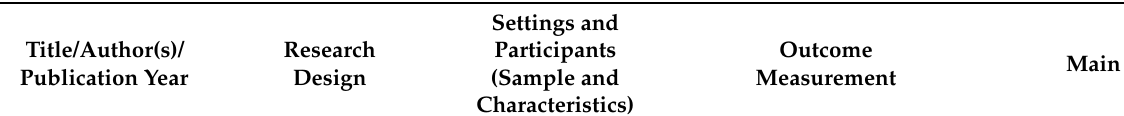
Table 1. Characteristics of included